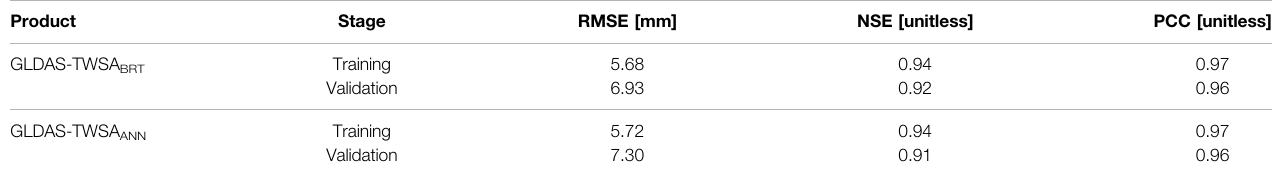
TABLE 2 | Summary statistics for the reconstructed GLDAS – VIC – TWSA based on BRT and ANN during the training stage and validation. The validation refers to the comparison between the reconstructed series and those observed in Figure 7 , that is, the closed-loop simulation.